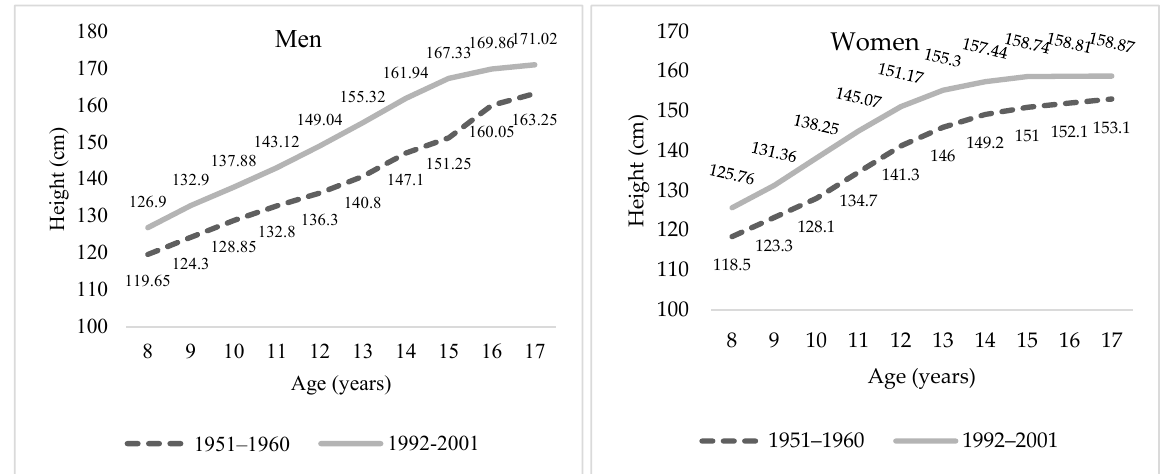
Figure 4. Median height evolution between children aged 8–17 years by sex. Sources: Authors’ calculations based on Luna–Jaspe et al.[2] and Durán et al. [36]